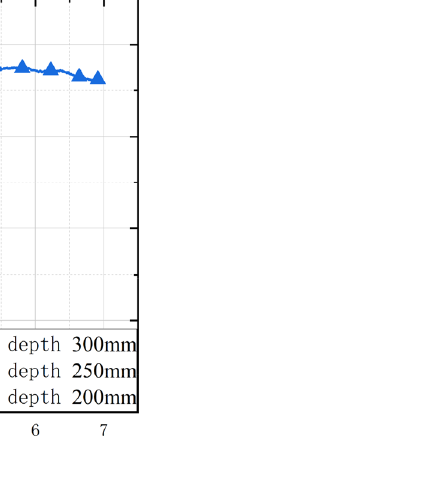
Figure 8. Pile top Q-s curves with different burial depths.